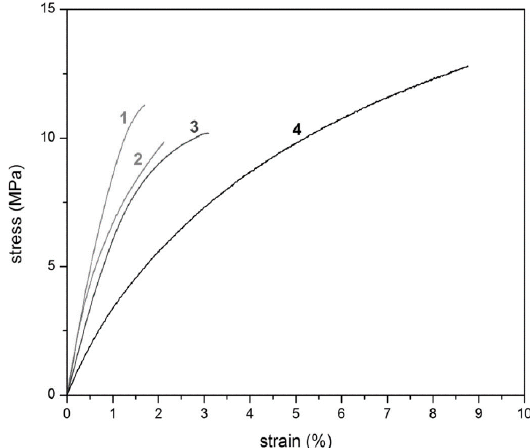
Figure 11. The stress–strain curves of polymer films obtained at room temperature for samples (1) poly(PFMMD), (2) poly(PFMMD- co -CTFE) (23 mol% CTFE), (3) poly(PFMMD- co -CTFE) (30 mol% CTFE), and (4) poly(PFMMD- co -CTFE) (50 mol% CTFE) [26].